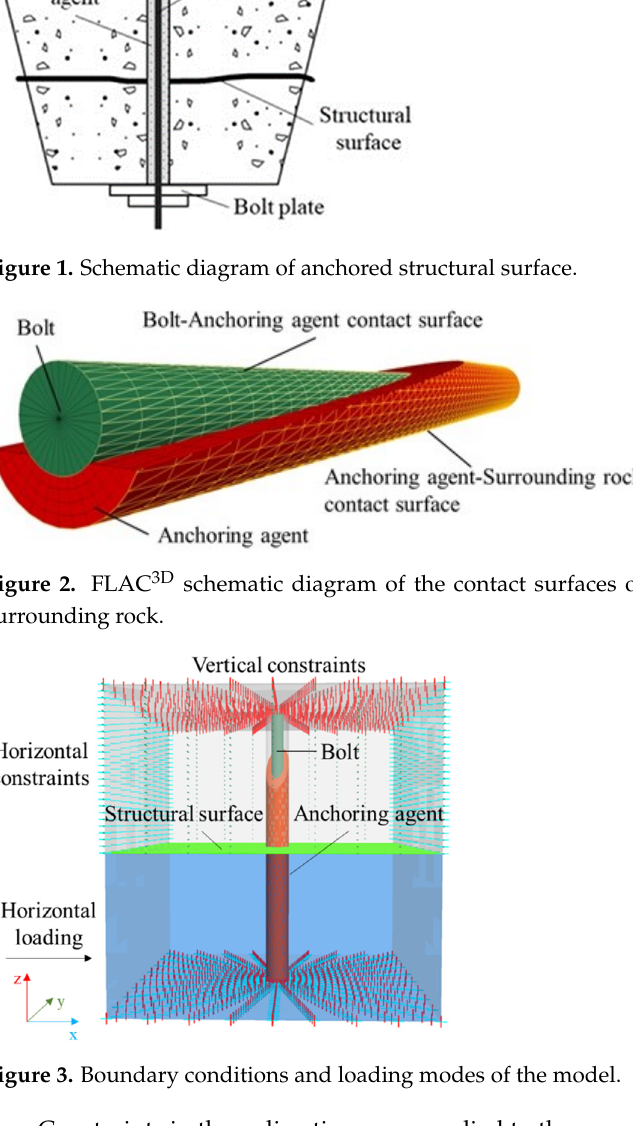
Table 1. Mechanical parameters of surrounding rock mass and anchoring agent. Name